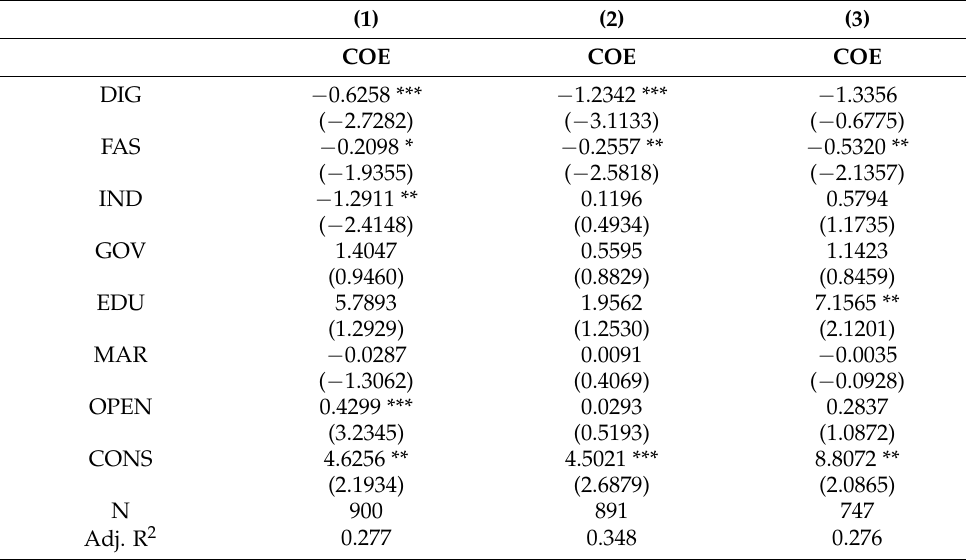
Table 11. Regional heterogeneity in east, central and west China.